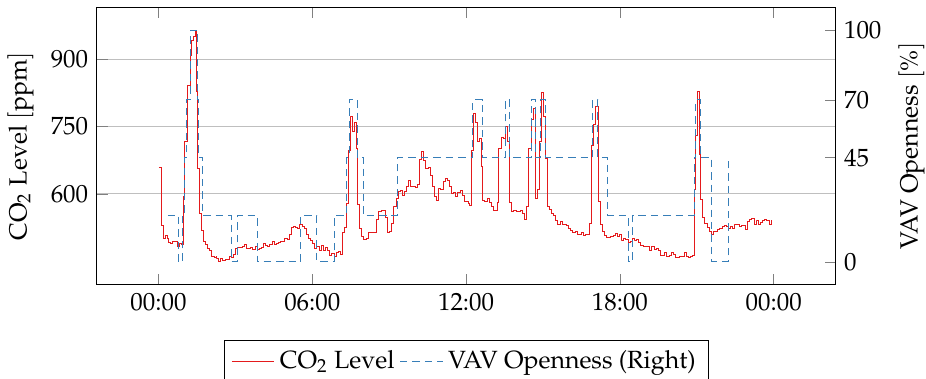
Figure 11. Correct behaviour of room ventilation. The VAV unit opens at the expected levels when CO 2 level rises over the thresholds.